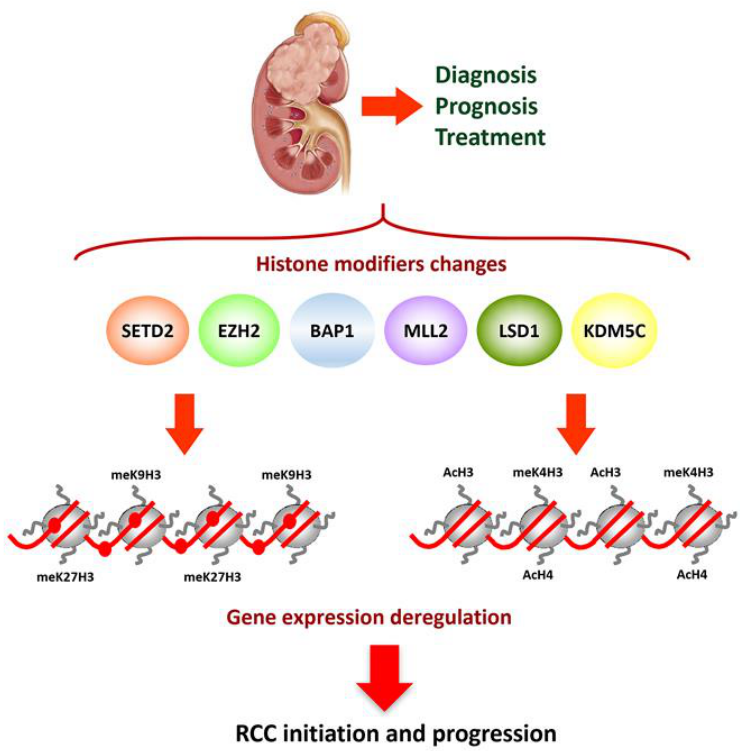
Figure 1. Summary of the altered histone modifiers genes in RCC. Histone modifiers changes induce gene expression deregulation and thus RCC initiation and progression. These alterations can be used as biomarkers for RCC diagnosis and prognosis. H3Ac, global acetylation of histone H3; meK9H3, methylated lys9 of Histone H3; meK27H3, methylated lys27 of Histone H3; meK4H3, methylated lys4 of Histone H3.